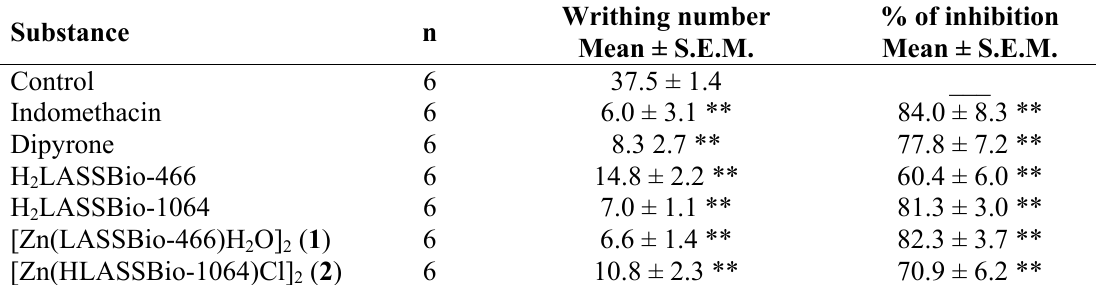
Table 3. Effect of H LASSBio-466, its regioisomer H 2 induced abdominal constrictions in mice, for a period of 25 min.